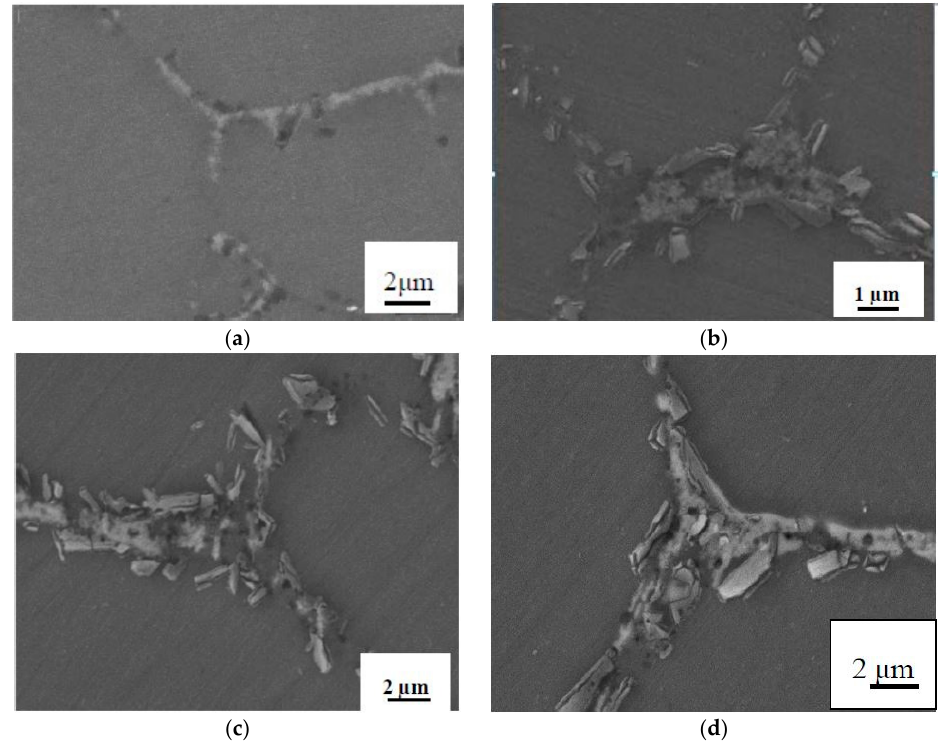
Figure 9. SEM micrographs of AA6061/5 vol.% N-SiC composites sintered at 450 ( a ), 550 ( b ), 600 ( c ) and 650 ( d ) °C.